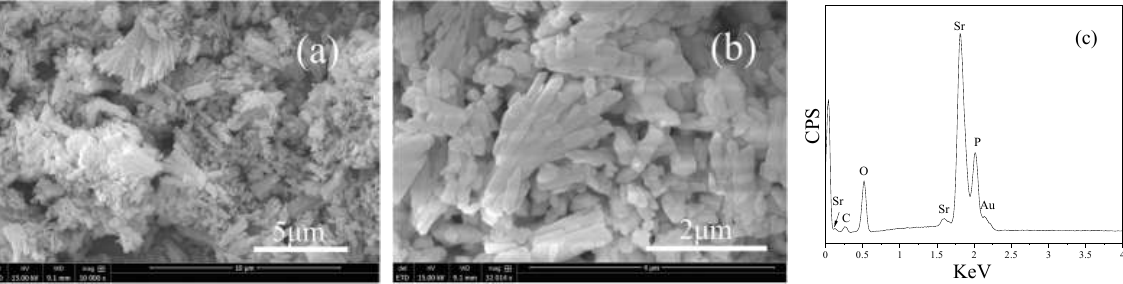
Figure 3. ( a , b ) SEM images and ( c ) EDS of α-SrHPO 4 .